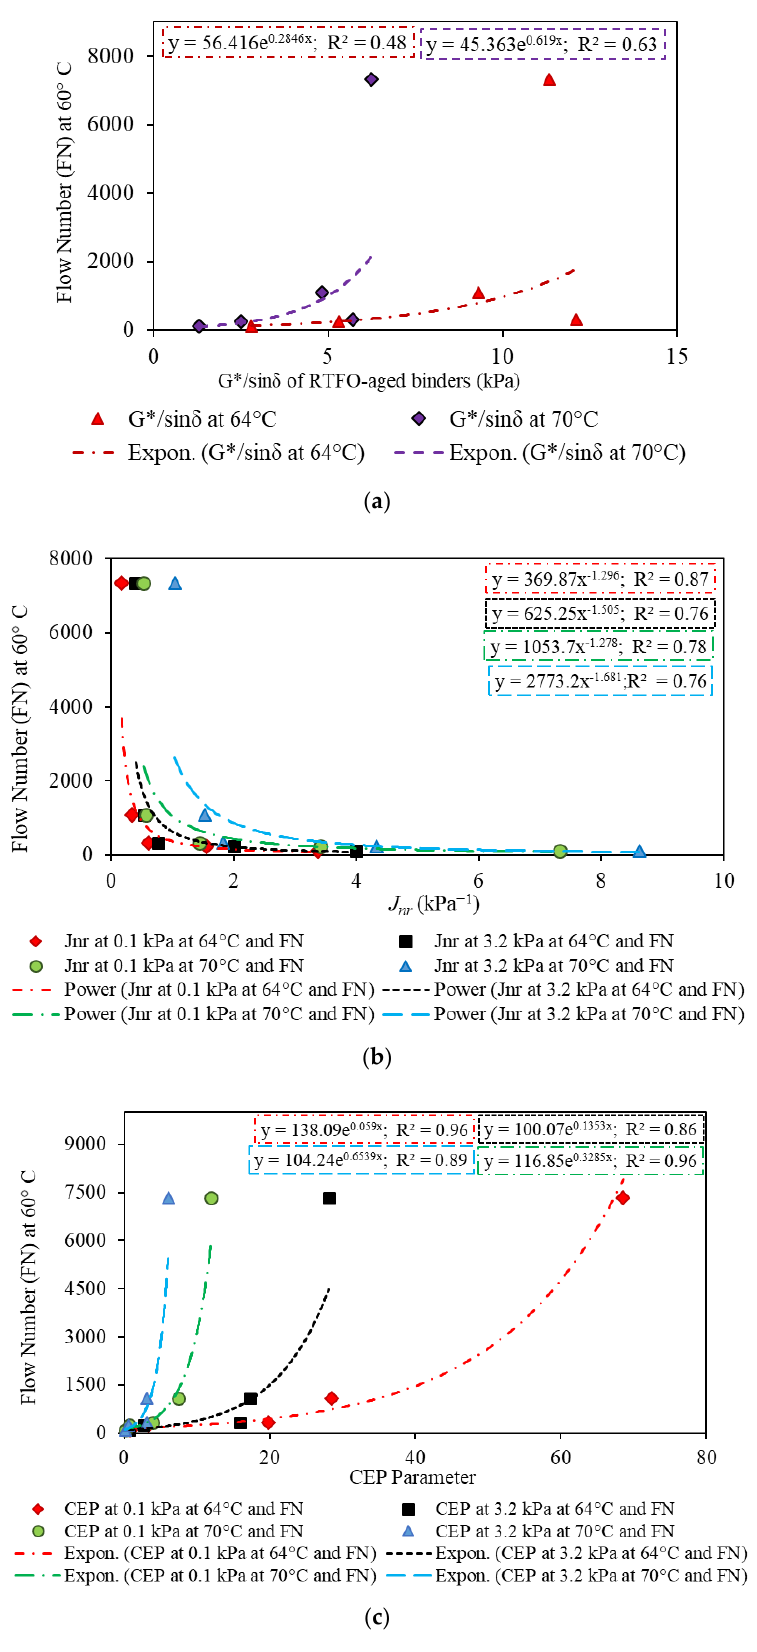
Figure 9. Correlations of Flow Number (FN) from the Dynamic Creep test with ( a ) G*/sin( δ ), ( b ) J nr , and ( c ) CEP